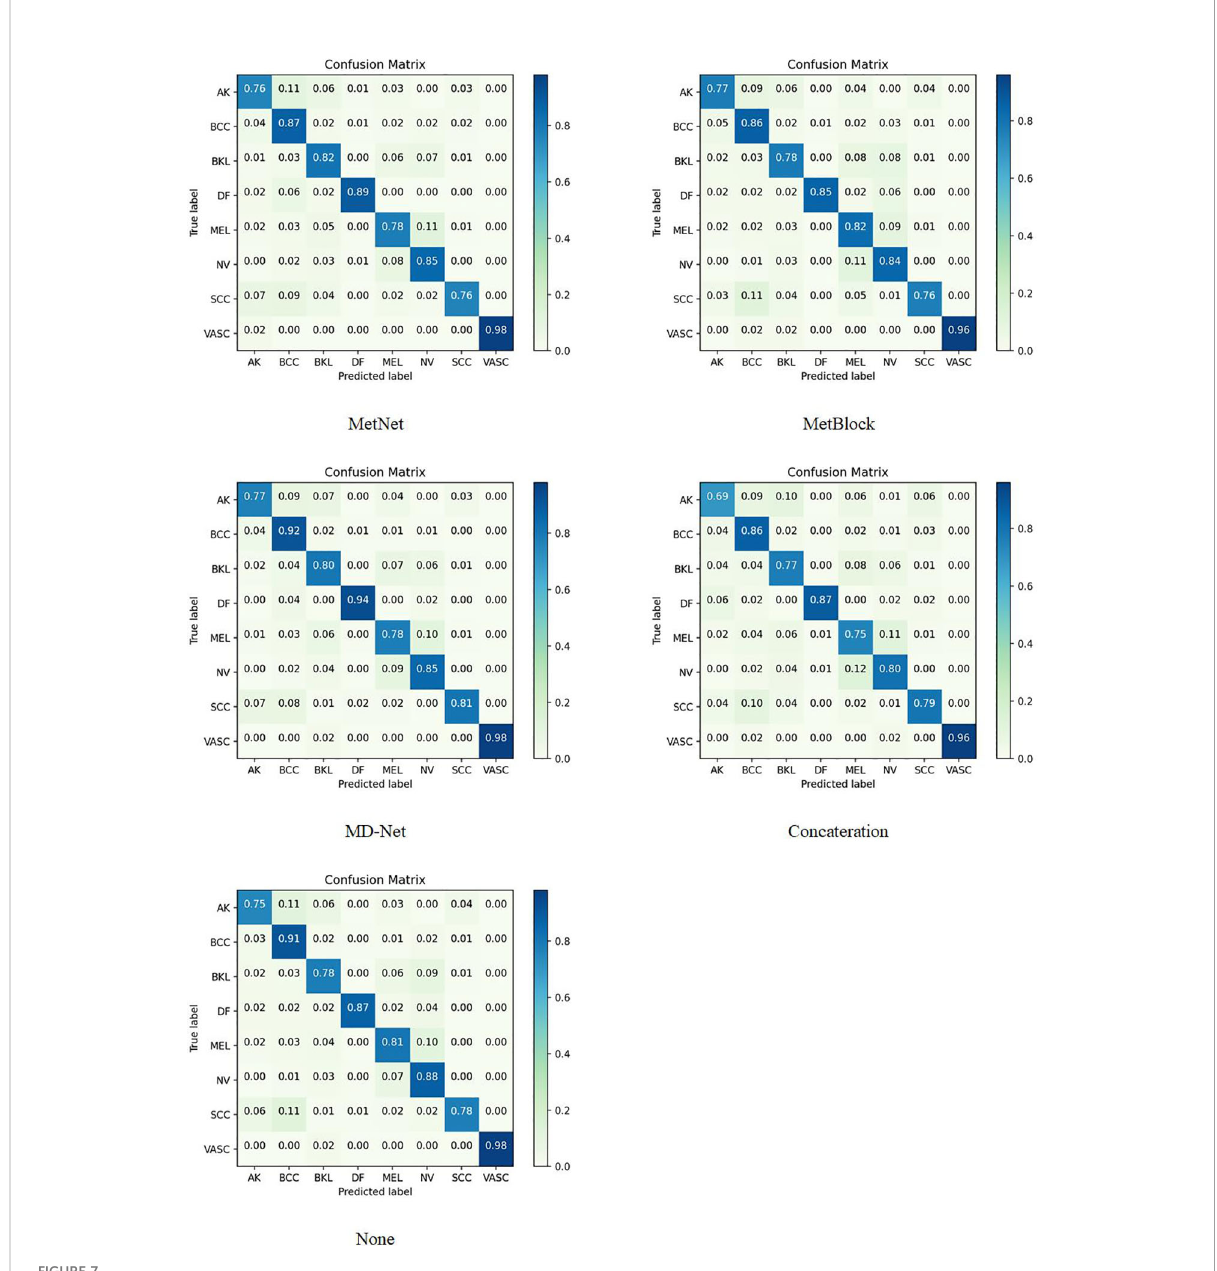
FIGURE 7 On the ISIC 2019 dataset, DenseNet169 combines the confusion matrix of different